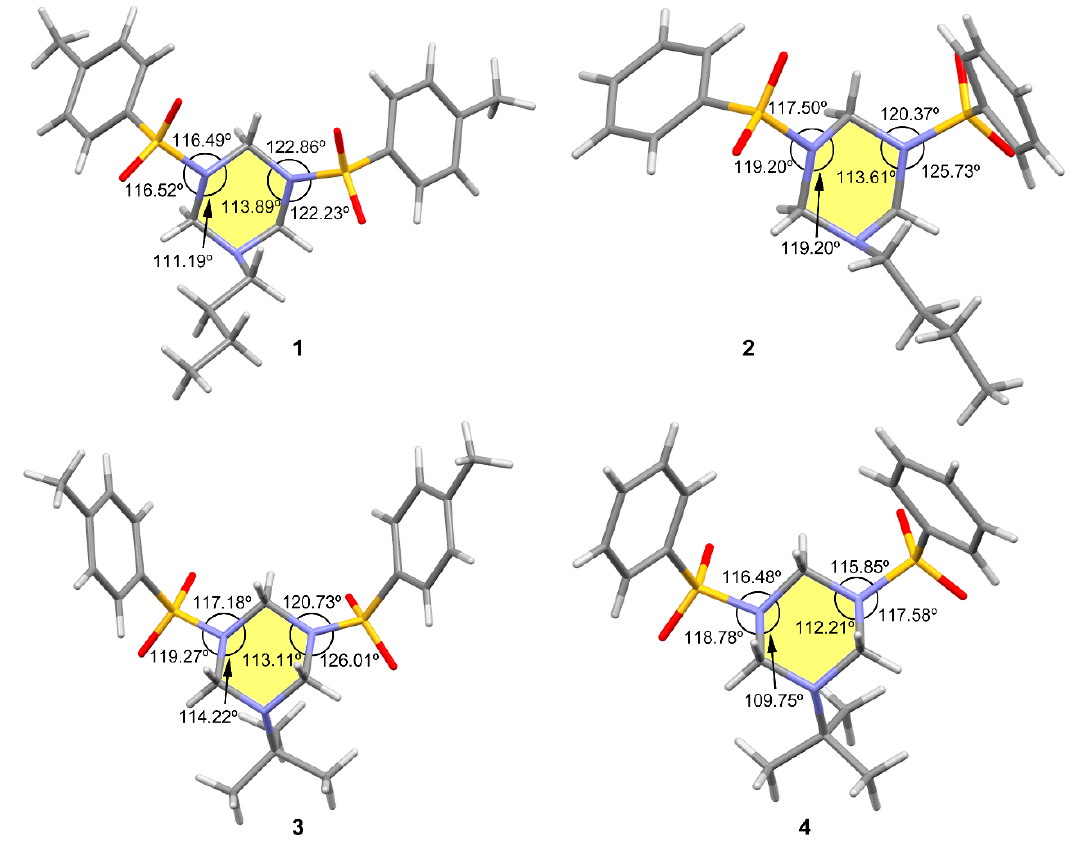
Figure 1. Single crystal X-ray diffraction structures of triazinanes 1 − 4 . Table 2. Sums of angles at the sulfonamide nitrogen atoms N3 and N5 and S–N distances in 1,3,5-triazinanes 1 – 4 .